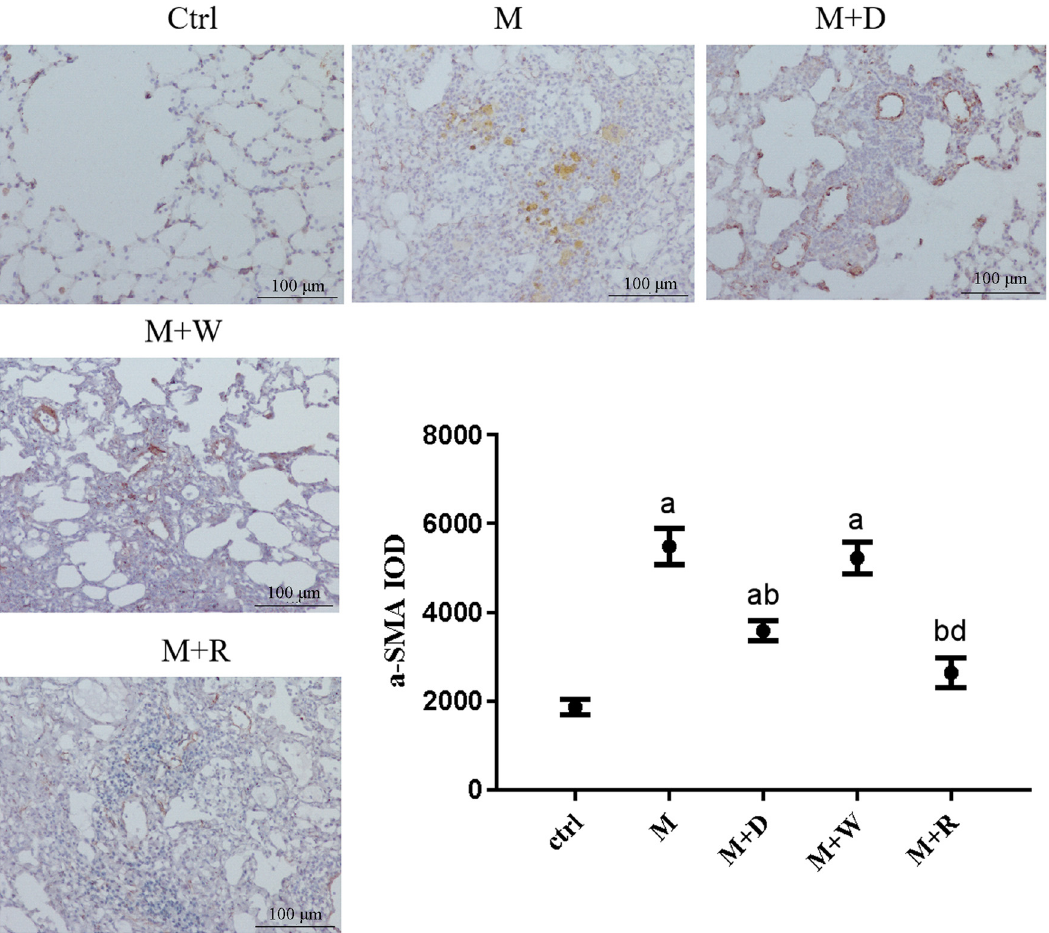
Figure 2: IHC image and expression levels of α - SMA, a fi brosis marker, in rat lung tissues of each group (× 200 ) : ( a ) statistically signi fi cant di ff erence from the Ctrl group ( P < 0.05 ) , ( b ) statistically signi fi cant di ff erence from the M group ( P < 0.05 ) , ( c ) statistically signi fi cant di ff erence from the M + D group ( P < 0.05 ) , and ( d ) statistically signi fi cant di ff erence from the M + R group ( P < 0.05 )